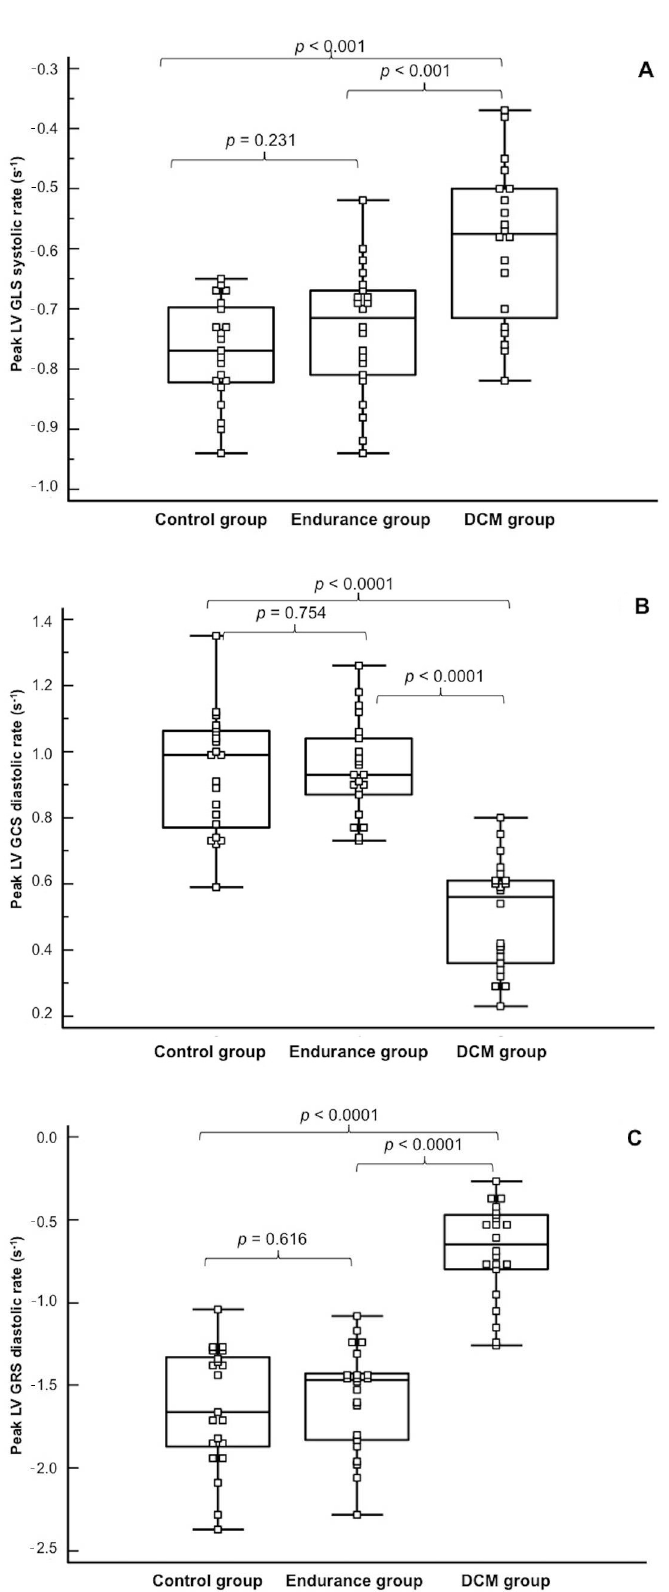
Figure 3. Comparison of the left ventricular peak global longitudinal systolic strain rate ( A ), global circumferential diastolic strain rate ( B ) and global radial diastolic strain rate ( C ) between the stud- ied groups.